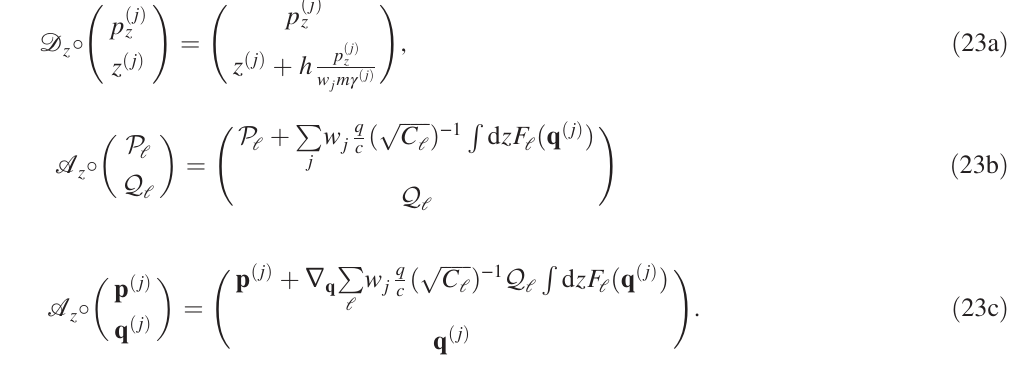
Table I. In all simulations, we considered four cavity modes: an accelerating mode, two transverse dipole modes,